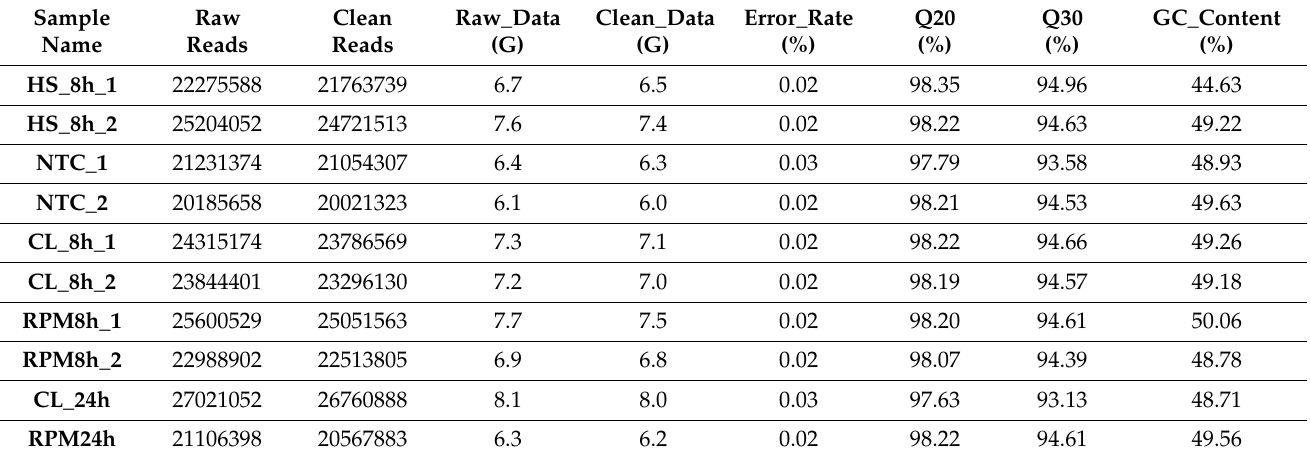
Table A5. RNA-seq data Quality Control summary.